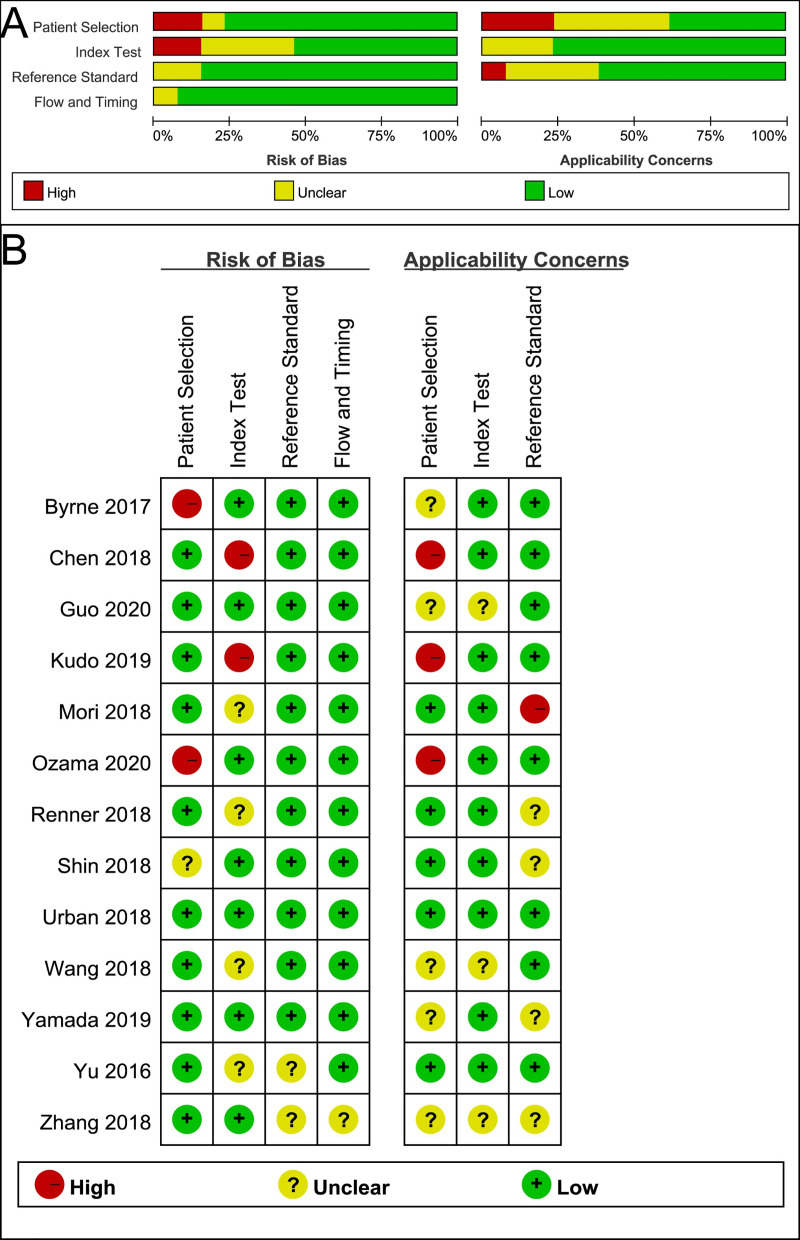
Methodological quality of the included 13 studies using assessment tool of QUADAS-2.(A) Grouped bar charts of risk of bias (left) and concerns for applicability (right). (B) Quality assessment for each individual study. QUADAS-2 = Quality Assessment of Diagnostic Accuracy Studies-2.